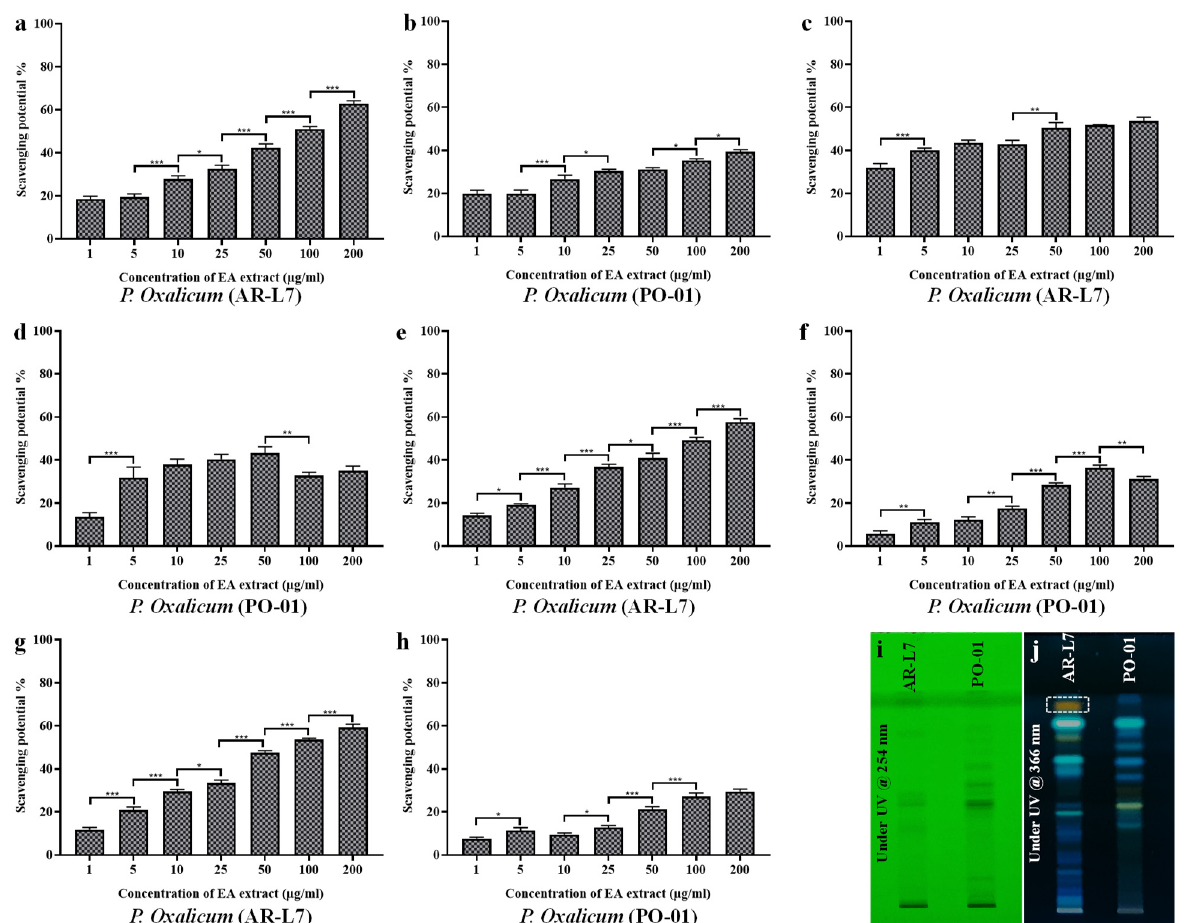
Figure 8. Comparative evaluation of antioxidant potential ( a , b ) DPPH free radical scavenging, ( c , d ) superoxide anion scavenging, ( e , f ) hydroxyl radical scavenging, and ( g , h ) nitric oxide scavenging for the EA extract of fungal strains P. Oxalicum (AR-L7) isolated from A. rohituka and P. Oxalicum (PO-01) isolated from rhizospheric soil of maize. All the experiments were performed in triplicate. p -value was calculated by comparing means ± SD of the free radical scavenging potential (%), using one-way ANOVA followed by Tukey to determine statistical significance. Statistical significances are as follows; *** p ≤ 0.001; ** p ≤ 0.002; * p ≤ 0.033. HPTLC fingerprint profiling of EA extract of fungal endophytes P. Oxalicum (AR-L7) and P. Oxalicum (PO-01) ( i ) image of TLC plate at 254 nm, ( j ) image of TLC plate at 366 nm.